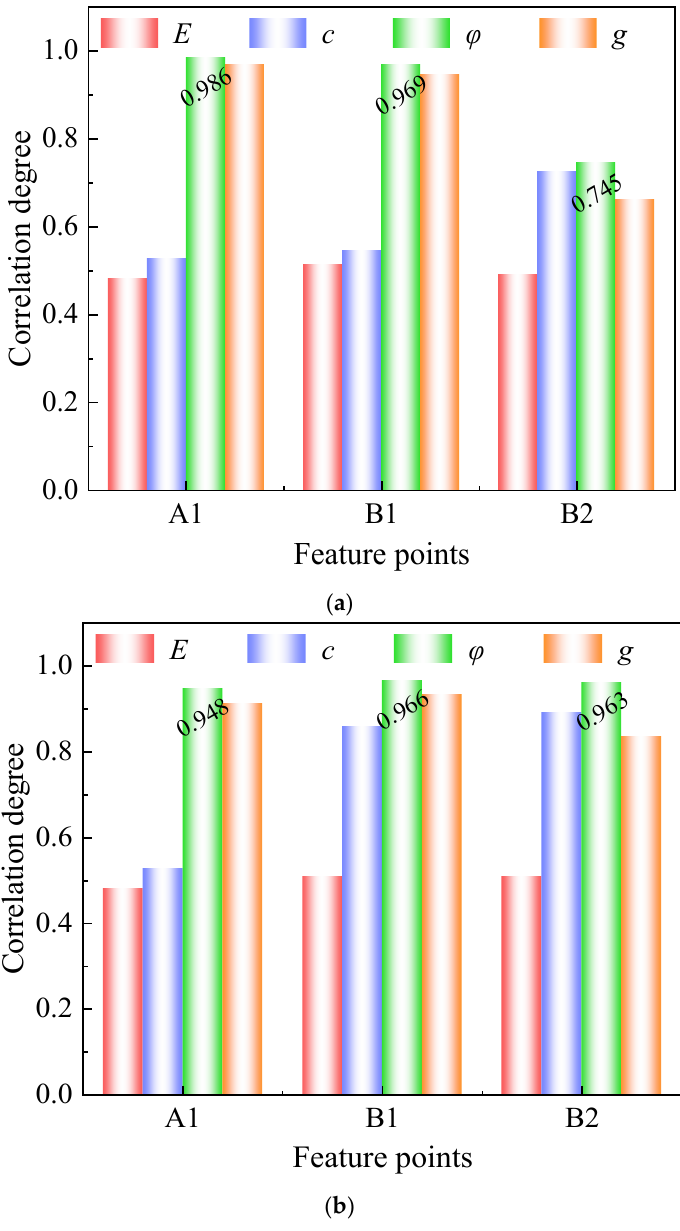
Figure 12. Structural feature point relational degree histogram. ( a ) Dynamic shear; ( b ) Dynamic bending moment.